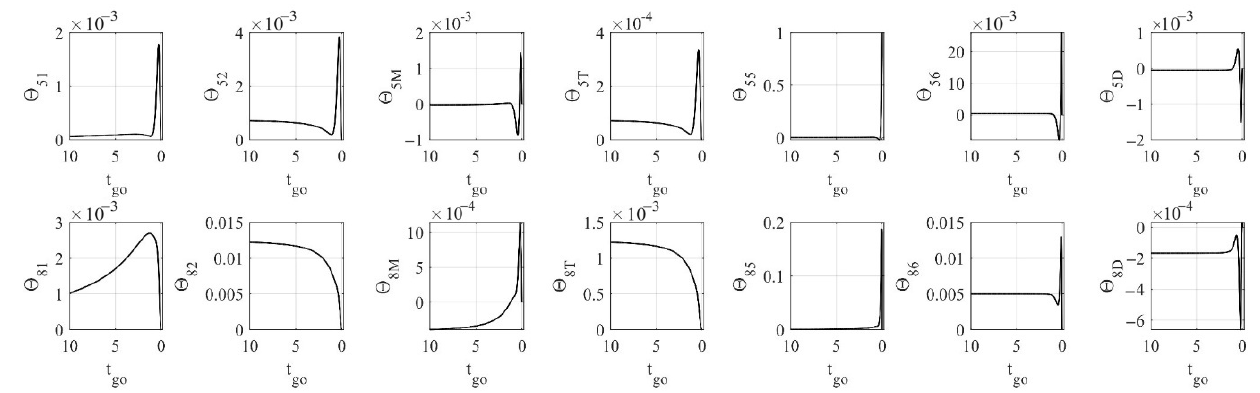
Figure 5. Transfer matrix elements for one-way cooperation with independent defender.